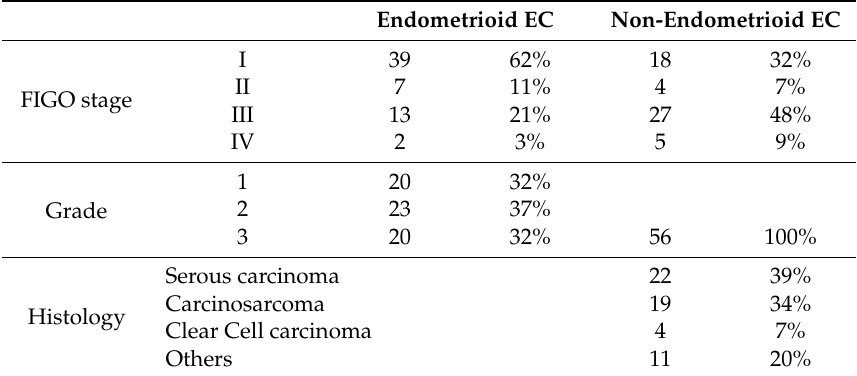
Table 2. ENITEC PDX models classified according to histology, stage, and differentiation